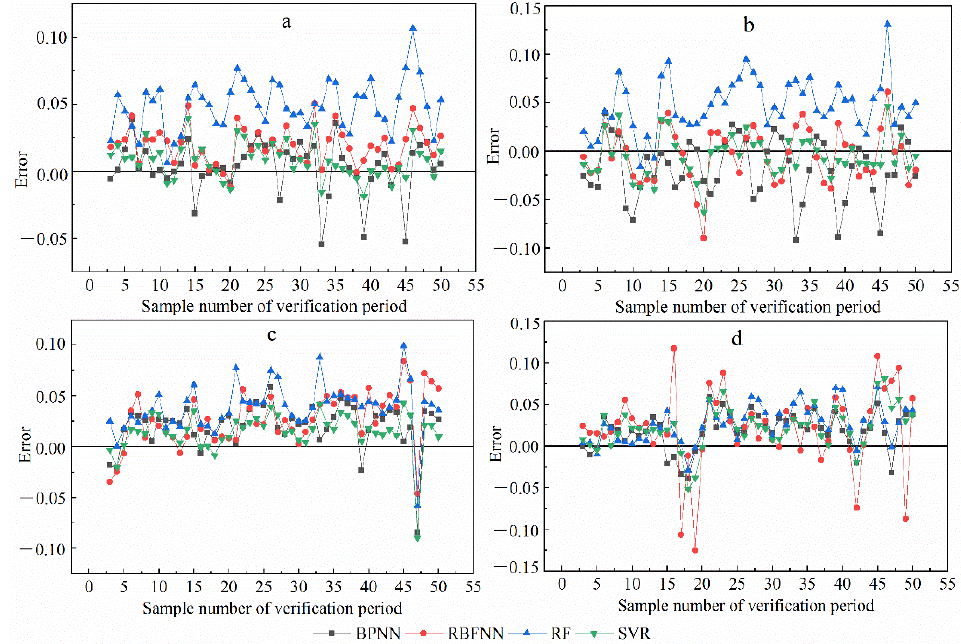
Figure 8. Error of the BPNN, RBFNN, RF, and SVR for the predicted NDVI in the ( a ) karst trough valley, ( b ) karst plateau, ( c ) karst peak-cluster depression, and ( d ) karst basin.